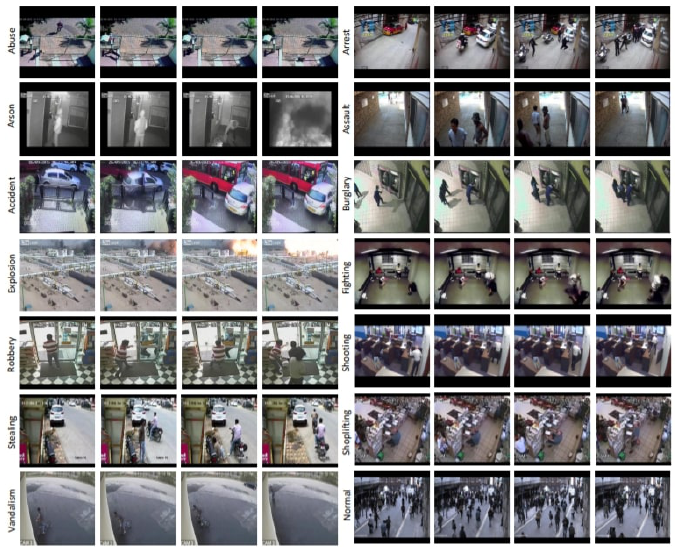
Figure 4. Examples of UCF-Crime